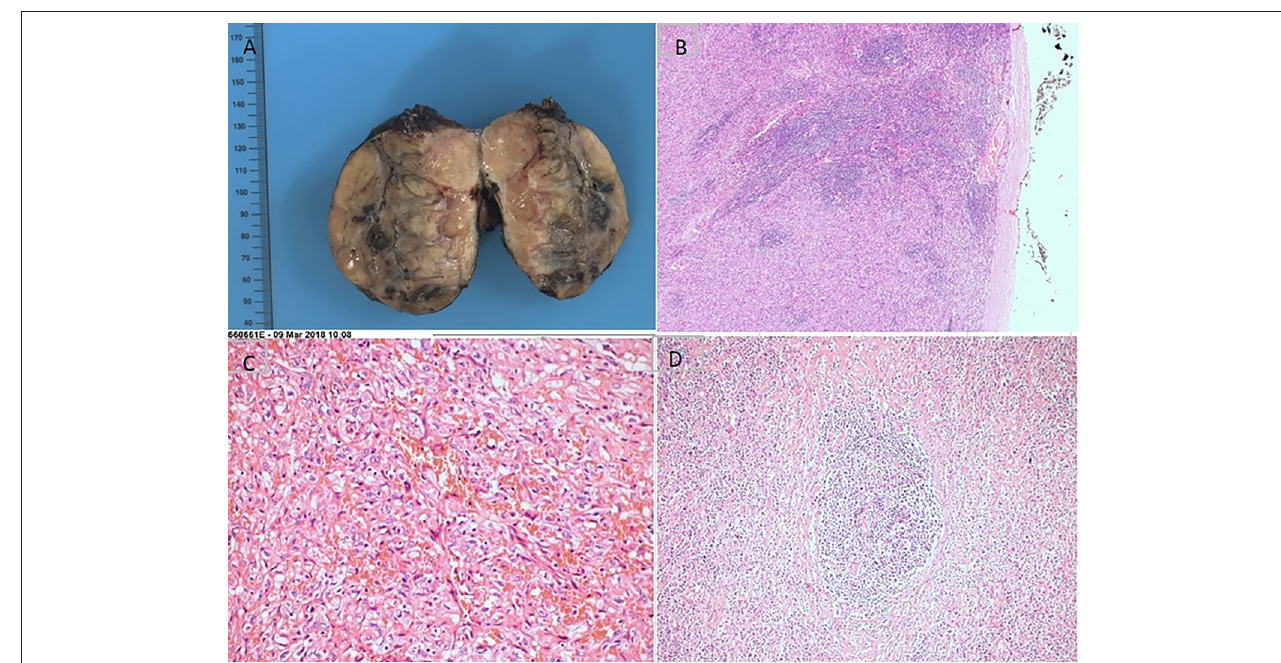
FIGURE 2 | Pathohistological features of mixed type Castleman disease. (A) The cutting surface; (B) the intact tumor envelope; (C) infiltrating neoplastic cells with marked pleomorphism; (D) rod-shaped glassy changes were seen in the germinal